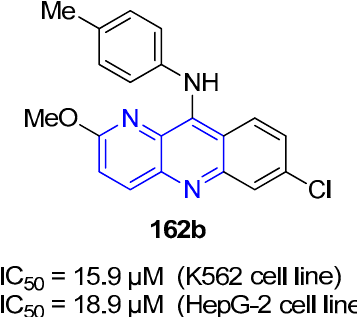
Figure 8. Cytotoxic activity of 162b on K562 and HepG-2 cell lines.